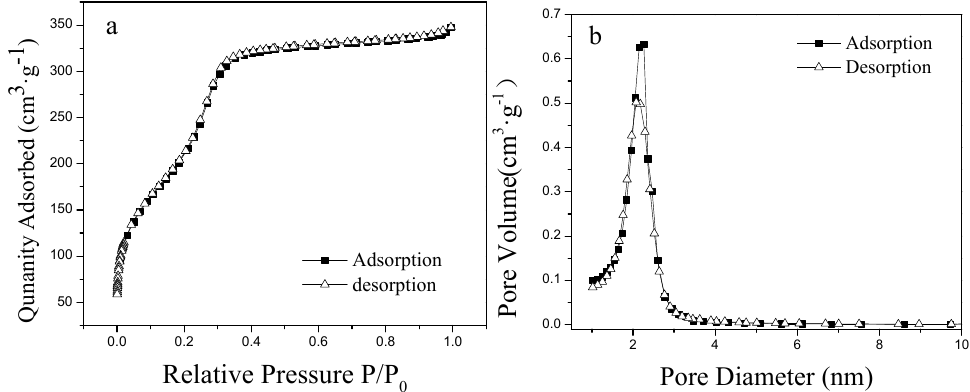
Figure 3. N 2 adsorption-desorption isotherms ( a ) and pore size distribution ( b ) of the phosphate imprinted mesoporous SiO 2 microspheres.